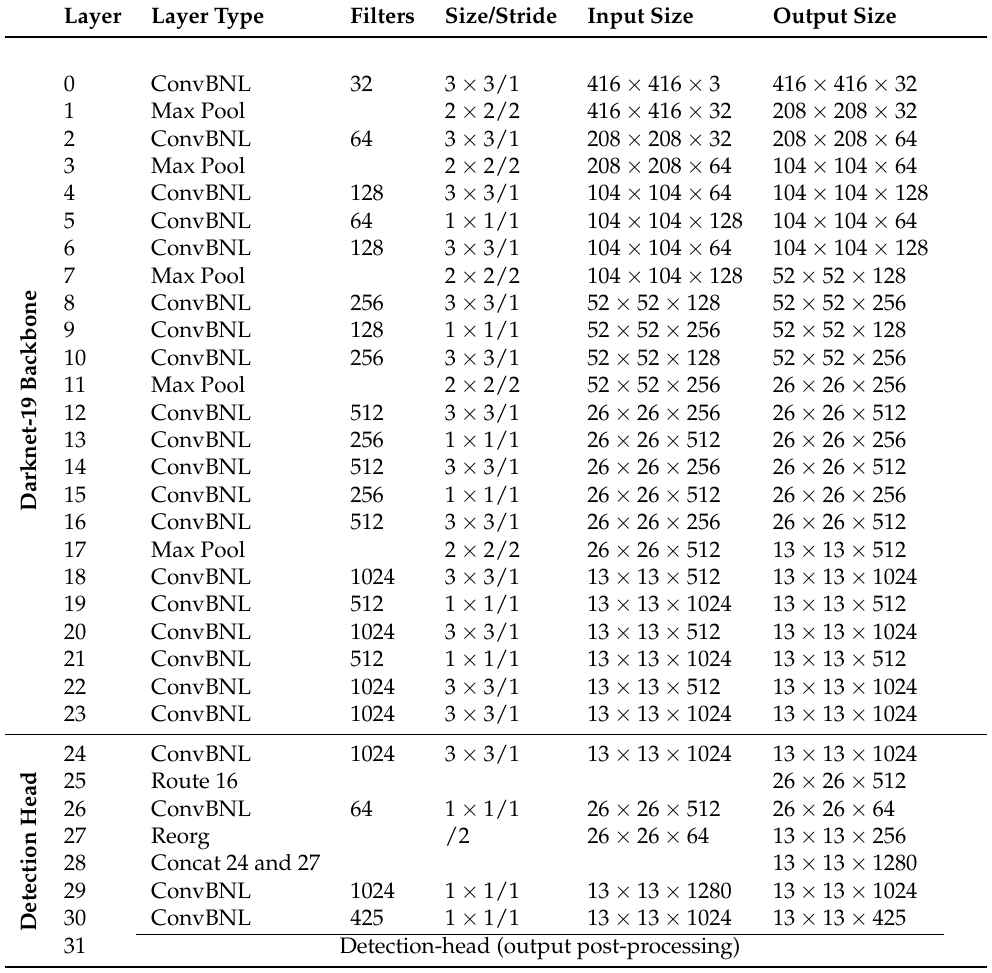
Figure 1. YOLOv2 object detection model layers and their corresponding tensor shapes. ConvBNL stands for convolution followed by batch normalization and Leaky Relu activation layers. Numbers 0–31 show the YOLOv2 layers. For a detailed understanding of each layer’s parameter size, refer to Table 1. Table 1. YOLOv2 layers and their input and output sizes presented in detail.